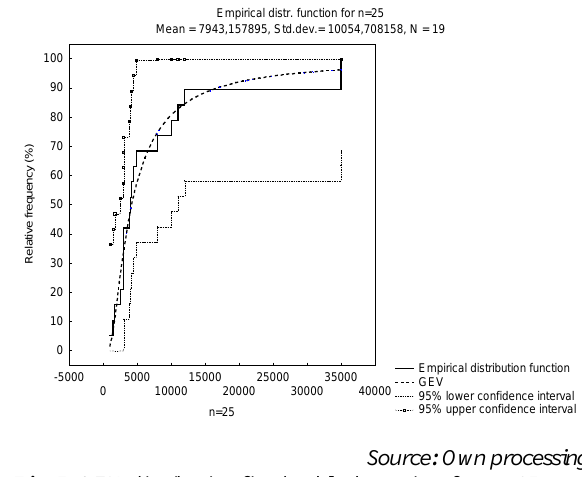
Fig. 5. GEV distribution fitted to block maxima for n = 25